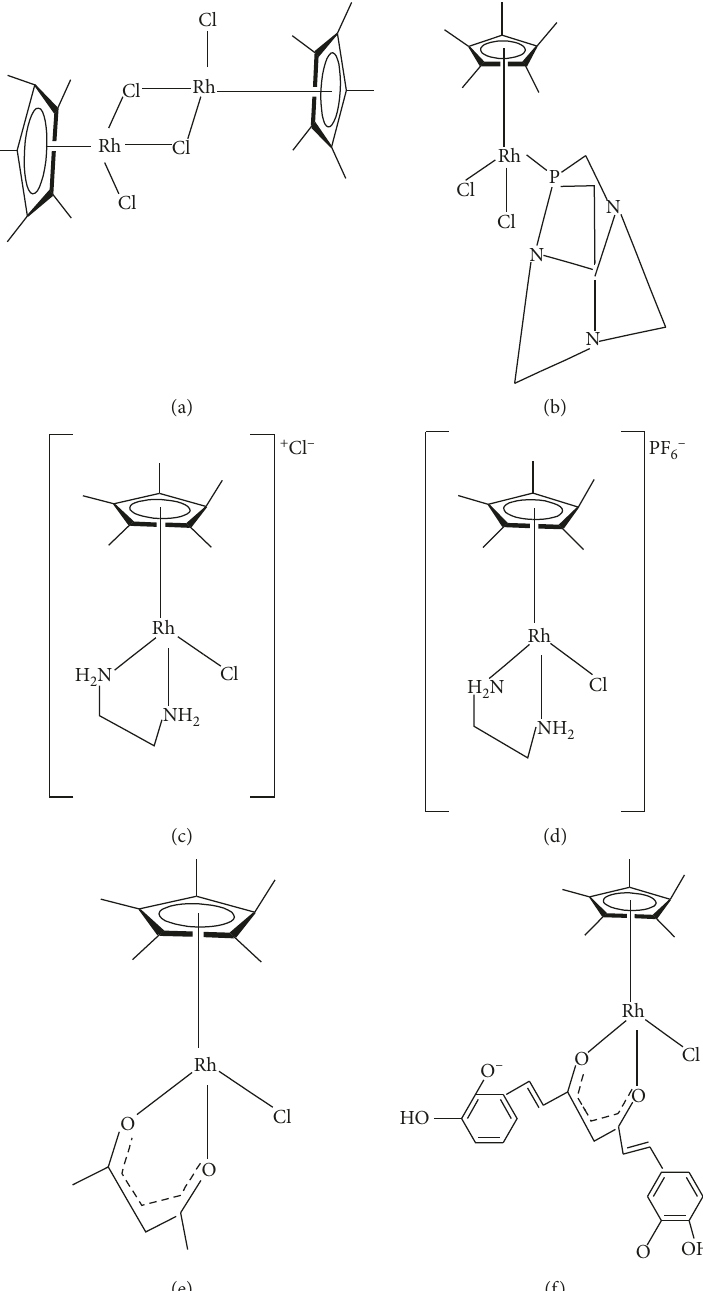
∗ Cp)Cl 2 . (b) [Rh( 2 (PTA)].